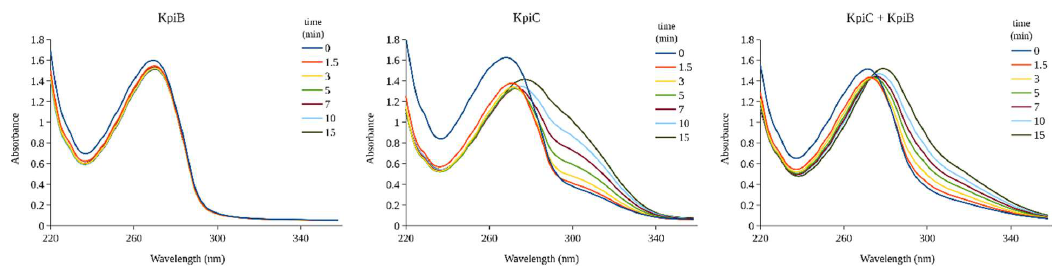
Figure 3. Bioconversion of 34DHP with the cell-free extracts of Escherichia . coli BL21 (DE3) expressing recombinant proteins (KpiB, KpiC, or both). The cell-free extracts were incubated in potassium phosphate buffer supplemented with 0.5 mM 34DHP, and the UV-VIS absorption spectra were recorded. The lines represent the progress of the reaction (time in minutes).